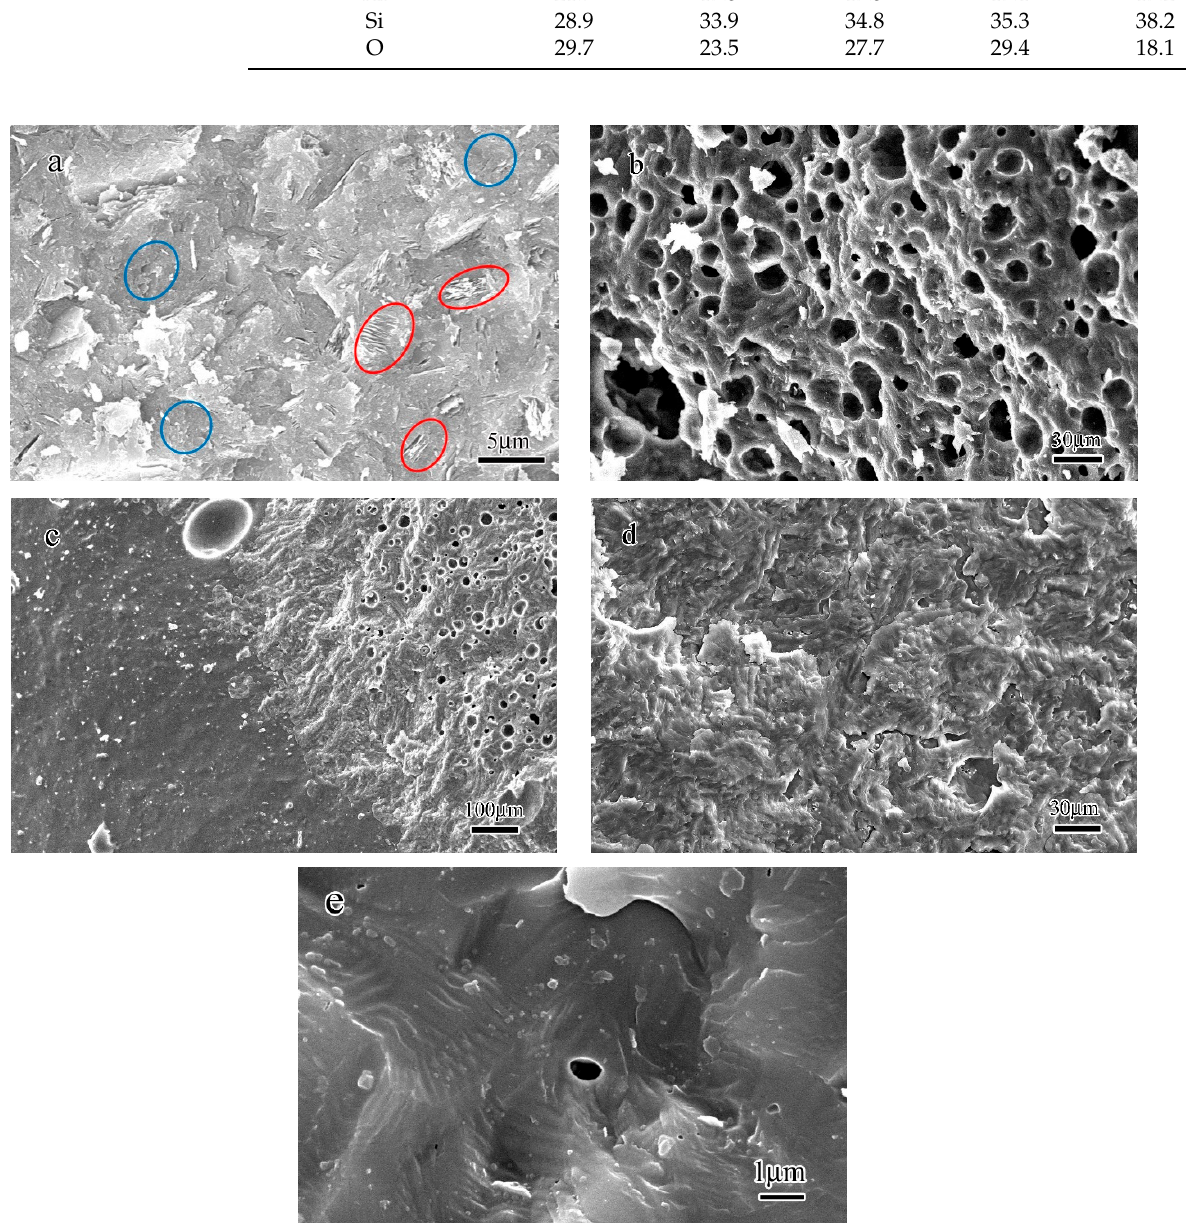
Figure 2. XRD pattern of the geopolymer materials calcined at various temperatures. (a) 1000 °C, (b)